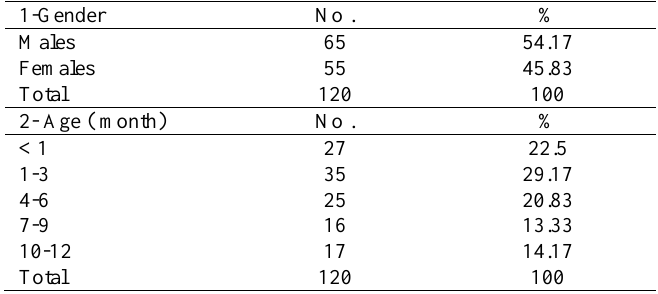
Table 1: Gender and age distribution of whole sample